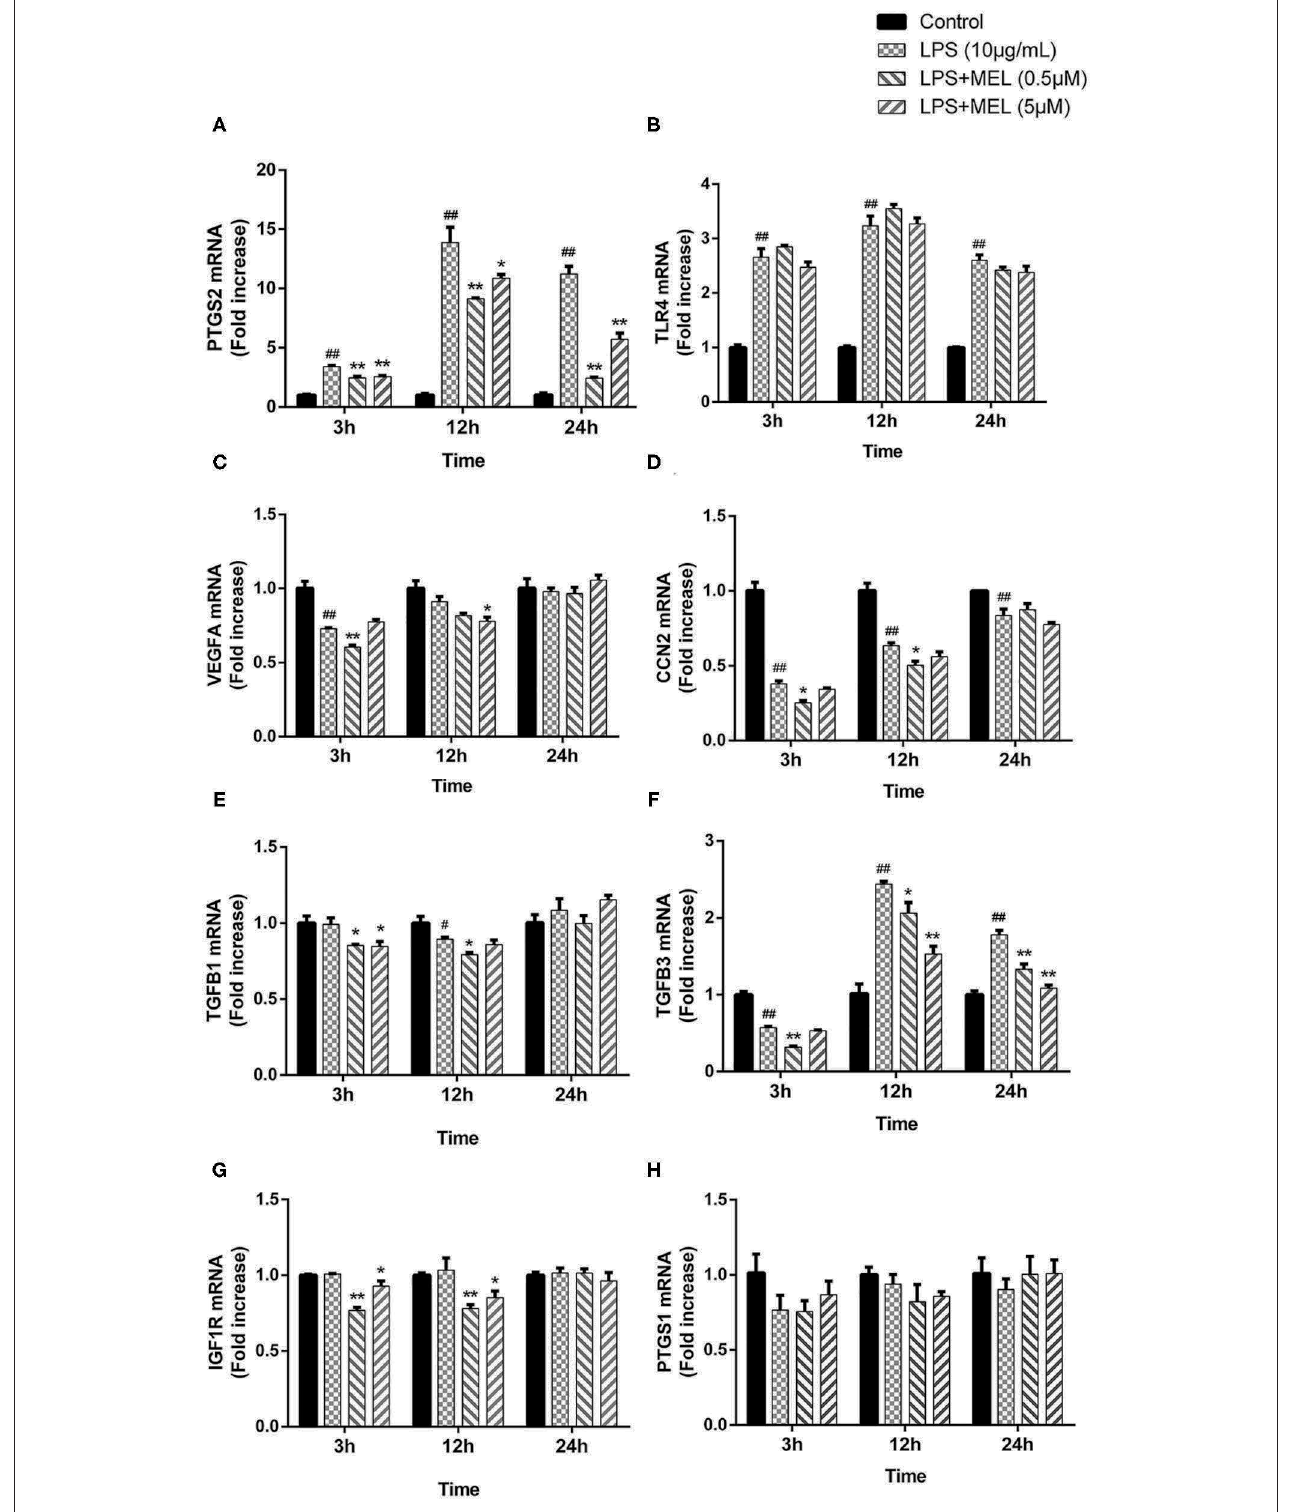
FIGURE 8 | The effect of meloxicam on the mRNA expressions of PTGS2 (A) , TLR4 (B) , VEGFA (C) , CCN2 (D) , TGFB1 (E) , TGFB3 (F) , IGF1R (G) , and PTGS1 (H) in bovine endometrial epithelial cells stimulated with lipopolysaccharide. LPS, lipopolysaccharide; MEL, meloxicam. The cells were treated with LPS or co-treated